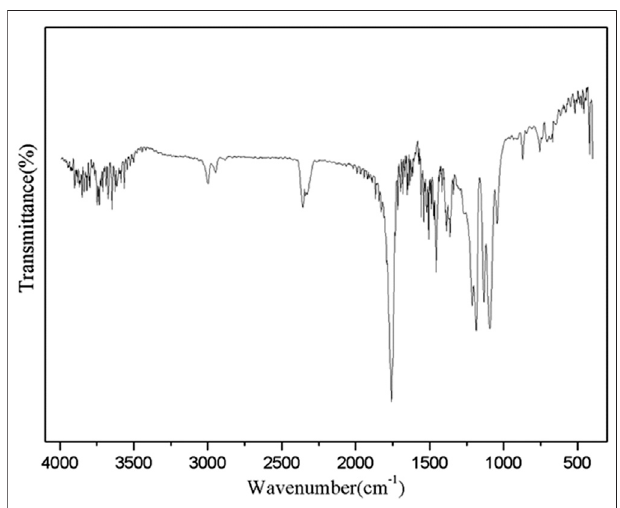
Figure 2 | FTIR spectra of polylactic acid